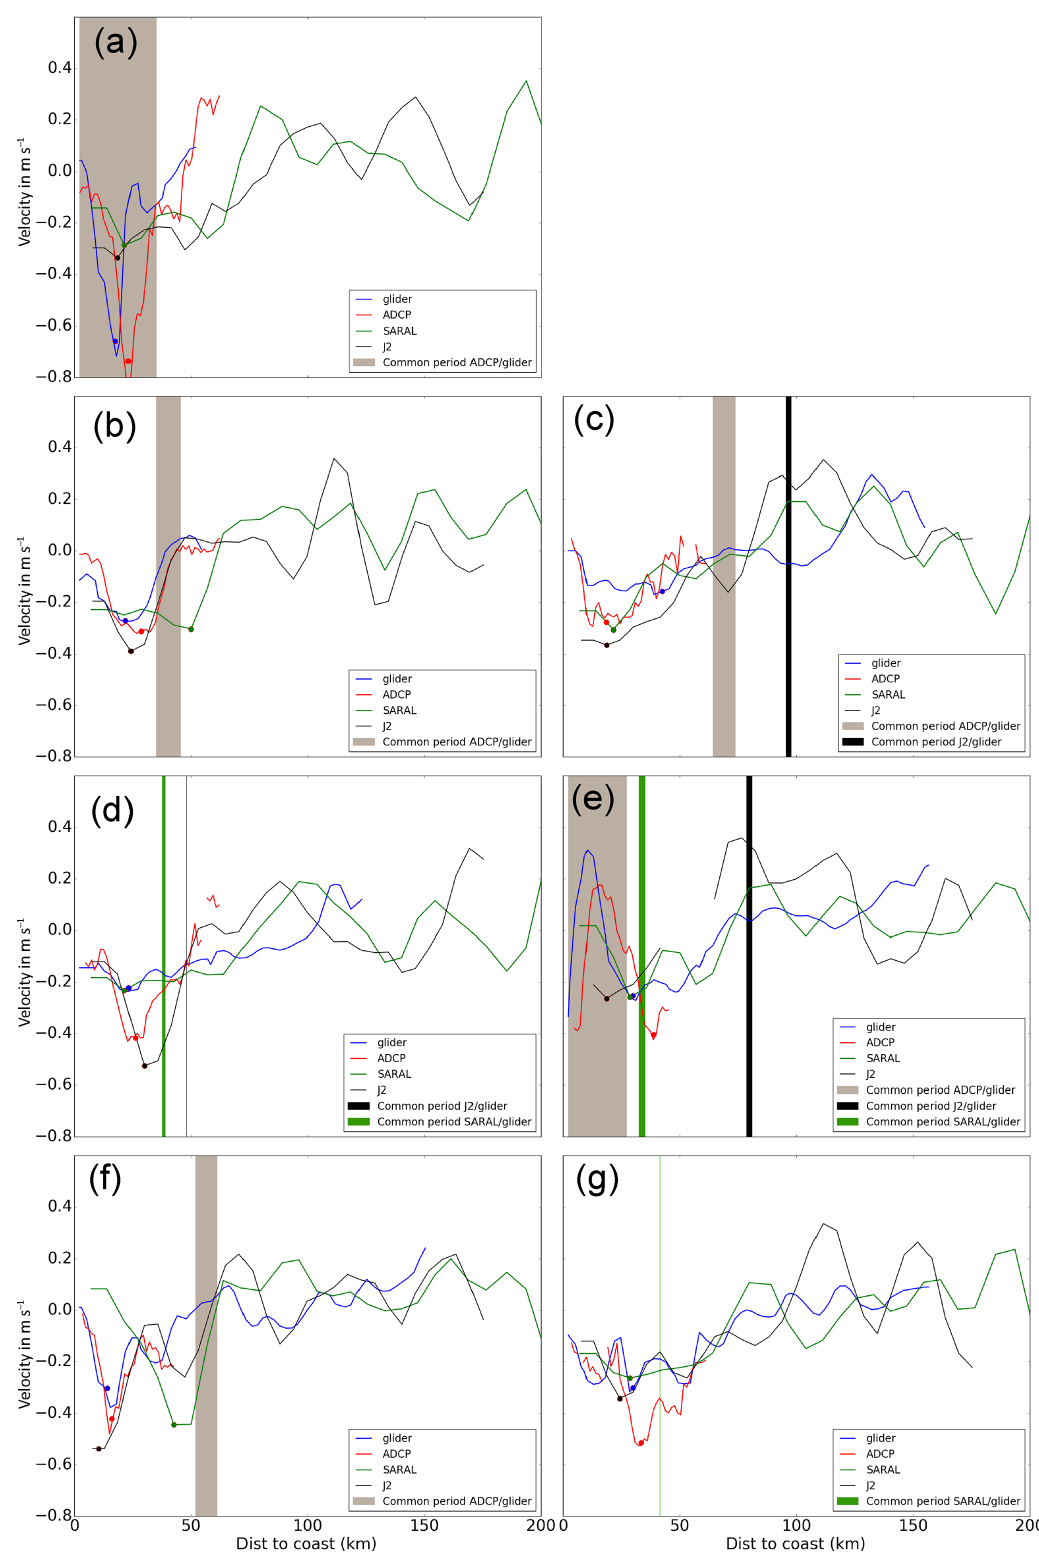
Figure 6. Cross-shore sections of currents deduced from the glider (blue), ADCP (red), SARAL (green) and J2 (black) altimetry data for the seven individual cases identified in Table 3. Overlapping periods between the different observations are also